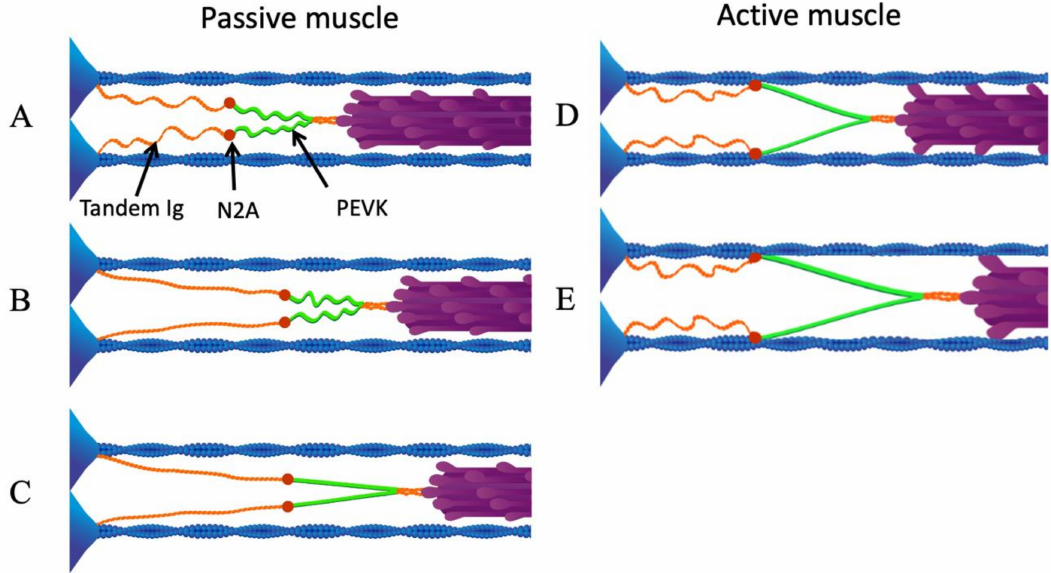
Figure 3. N2A—actin interaction eliminates low-force straightening of tandem Ig domains. ( A ) Passive sarcomere at slack length. ( B ) As the sarcomere is stretched passively beyond its slack length, the proximal tandem Ig segments unfold approximately to their contour length. ( C ) After the proximal tandem Ig segments have reached their contour length, further passive stretching extends the PEVK segment. ( D ) Upon activation, N2A titin binds to actin. ( E ) When the active sarcomere is stretched, only the PEVK segment (green) extends. Reproduced with permission from Nishikawa [21]. Copyright 2016, The Company of Biologists